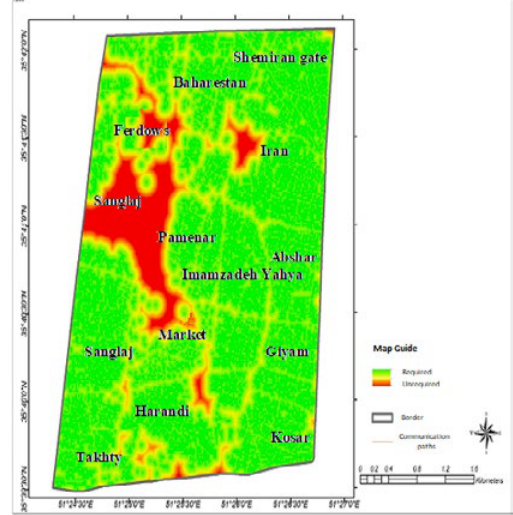
Fig. 15: Raster distance layer from residential centers of the District Fig. 16: Fuzzy distance layer from residential centers of the District